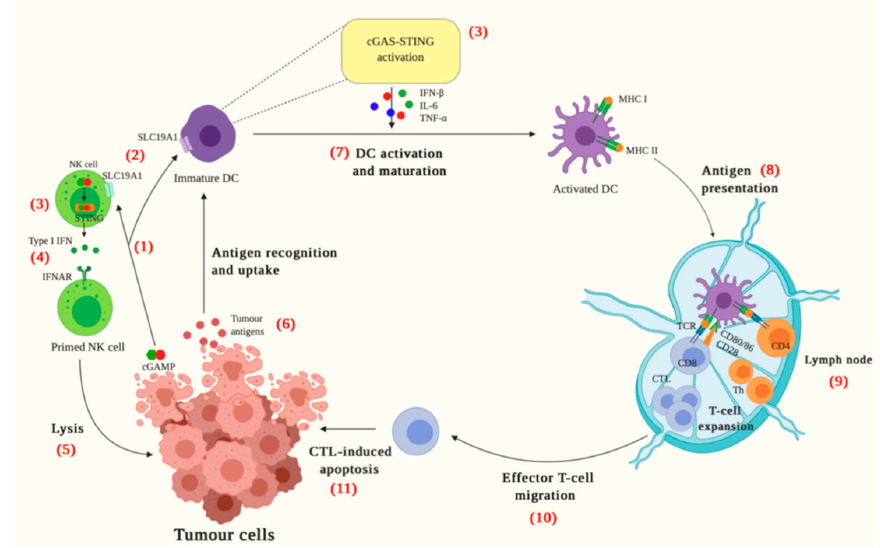
Figure 2. A schematic diagram of the role of the cGAS-STING pathway in cancer immunity.